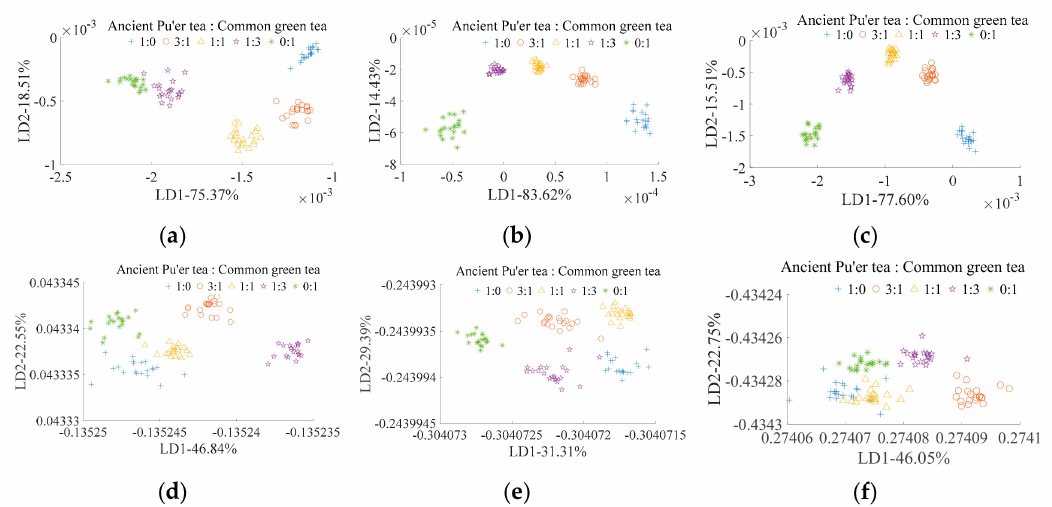
Figure 7. LDA for ancient Pu’er tea discrimination based on E-nose. ( a – c ) are traditional feature extraction; ( d – f ) are CNN feature extraction; ( a , d ) are E-nose detection; ( b , e ) are VIS / NIR spectrometer detection; and, ( c , f ) are multi-information fusion